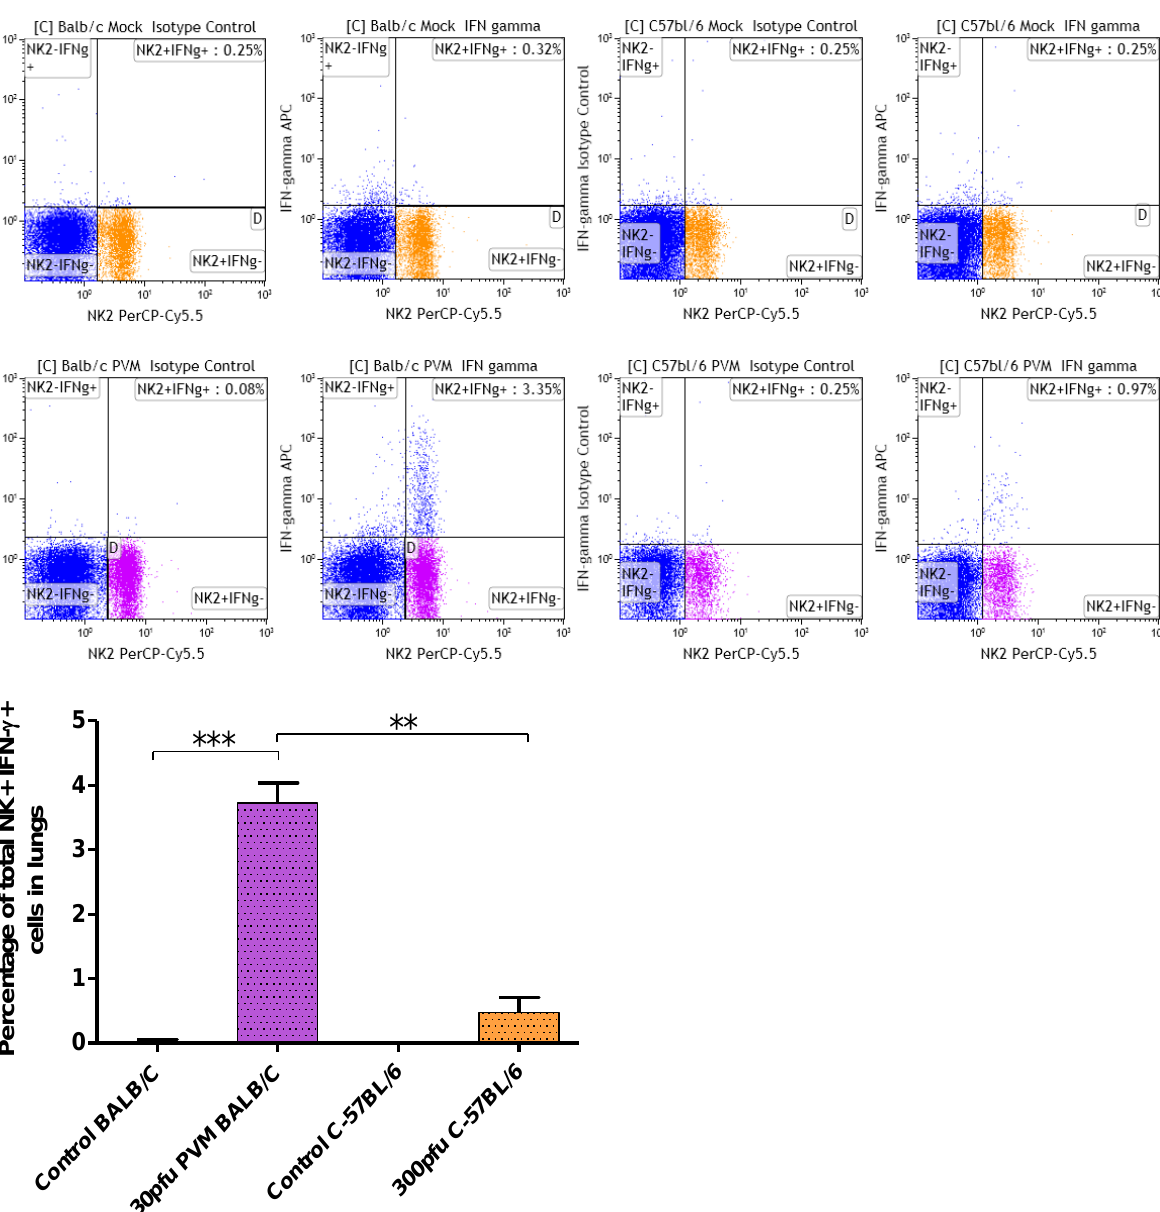
Figure 6. Percentage of IFN-γ secreting NK cells in lungs of Balb/c and C57Bl/6 mice in response to PVM infection. Five to six week old-mice were inoculated with medium (control), or 30 pfu (Balb/c), or 300 pfu (C57Bl/6) of PVM 15 and sacrificed on day 6 p.i.. Cells collected from pooled lungs of five animals were stained with anti-CD8a-FITC, anti-CD3-PE, anti-CD4-FITC, anti-CD335(NKp46)PerCP-Cy TM 5.5 for surface markers, followed by permeabilization and fixation with BD Cytofix/Cytoperm TM Plus and staining with anti-IFN-γ-APC. Flow cytometry